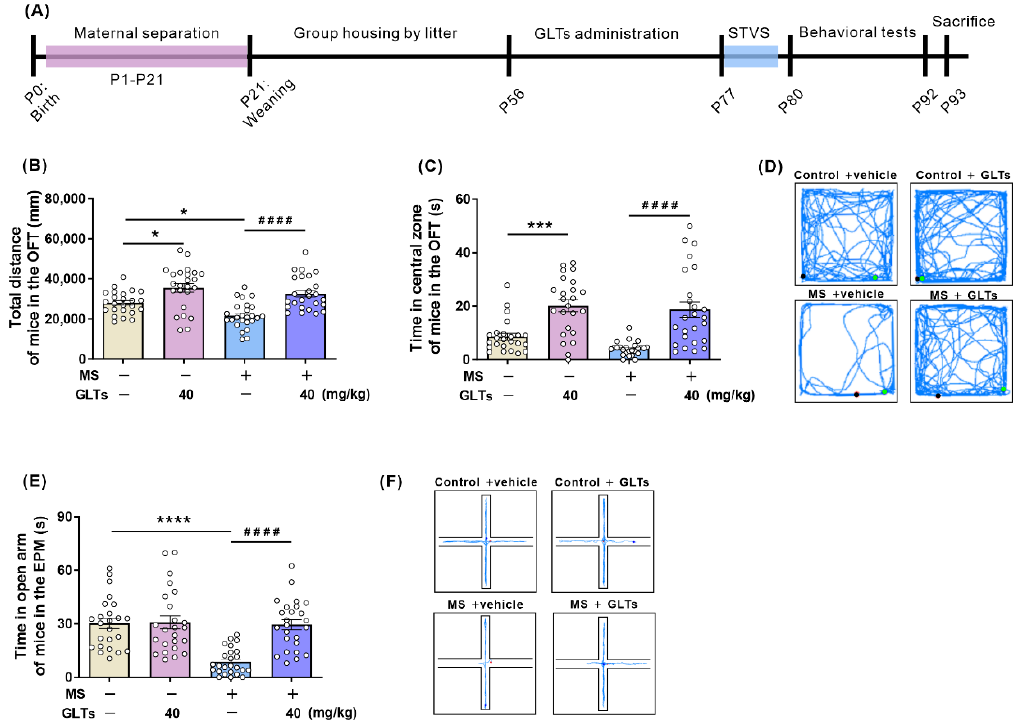
Figure 1. The reduced susceptibility to anxiety-like behaviors in maternally separated (MS) mice by preemptive ganoderma lucidum triterpenoids (GLTs) treatment. ( A ) Schematic diagram of maternal separation, GLTs treatment, sub-threshold variable stress (STVS), and behavioral tests. ( B ) Total distance and ( C ) time spent in the central zone of the open field test (OFT). ( D ) Representative road maps showing the movement trajectory of mice in the OFT. ( E ) Time spent in open arm of the elevated plus maze (EPM). ( F ) The typical movement tracking of mice in the EPM. Data are expressed as mean ± SEM. Control + vehicle group, n = 24 (male: n = 11; female: n = 13); Control + GLTs (40 mg/kg) group, n = 24 (male: n = 11; female: n = 13); MS + vehicle group, n = 25 (male: n = 12; female: n = 13); MS + GLTs (40 mg/kg) group, n = 25 (male: n = 12; female: n = 13). * p < 0.05, *** p < 0.001, **** p < 0.0001, as compared with Control + vehicle group; #### p < 0.0001, as compared with MS + vehicle group.